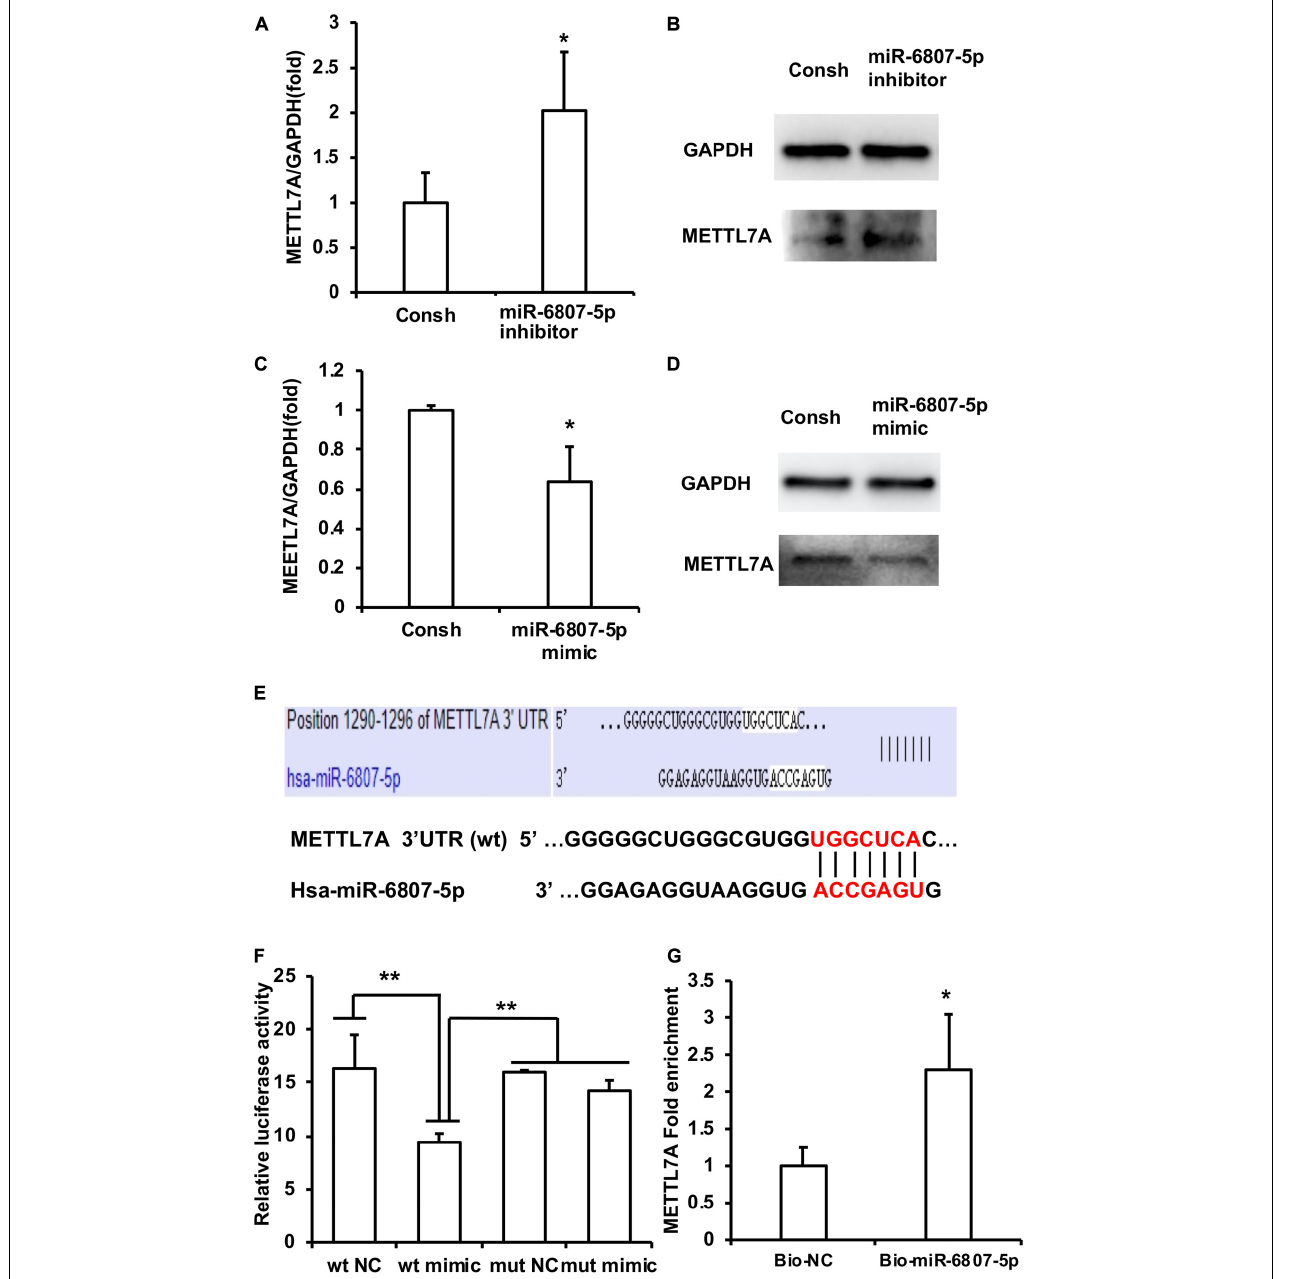
FIGURE 3 | METTL7A was identified as the downstream target gene of miR-6807-5p. (A,B) METTL7A was promoted in the miR-6807-5p inhibitor group detected by real-time RT-PCR and western blot. (C,D) METTL7A was repressed in the miR-6807-5p mimic group detected by real-time RT-PCR and western blot. (E) The binding site of miR-6807-5p in 3 (cid:48) UTR of METTL7A. (F) The miR-6807-5p binding to the 3 (cid:48) UTR of METTL7A was verified by the dual-luciferase reporter assay. (G) Results of the pull-down assay with biotinylated miRNA. GAPDH was used as internal control. Student’s t -test or Tukey’s post hoc tests used after one-way ANOVA were performed to determine statistical significance. All error bars represent the standard deviation ( n = 3). * p ≤ 0.05, ** p ≤